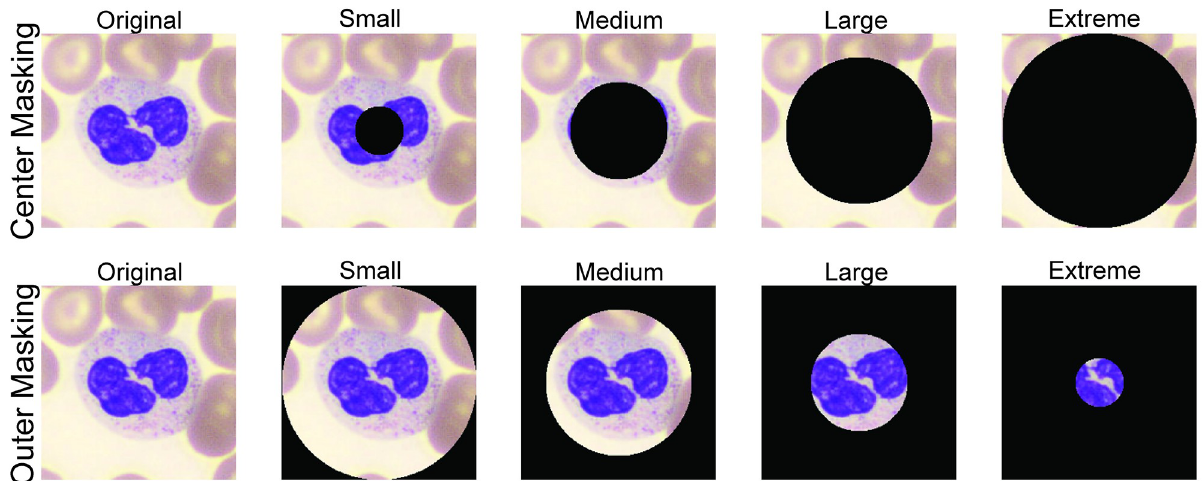
Fig 6. Visual image perturbations applied during training. Center masking occludes the white blood cell (which is always centered within the image). Outer masking occludes the red blood cells, which are in the area surrounding the white blood cell (towards the outside of the image).